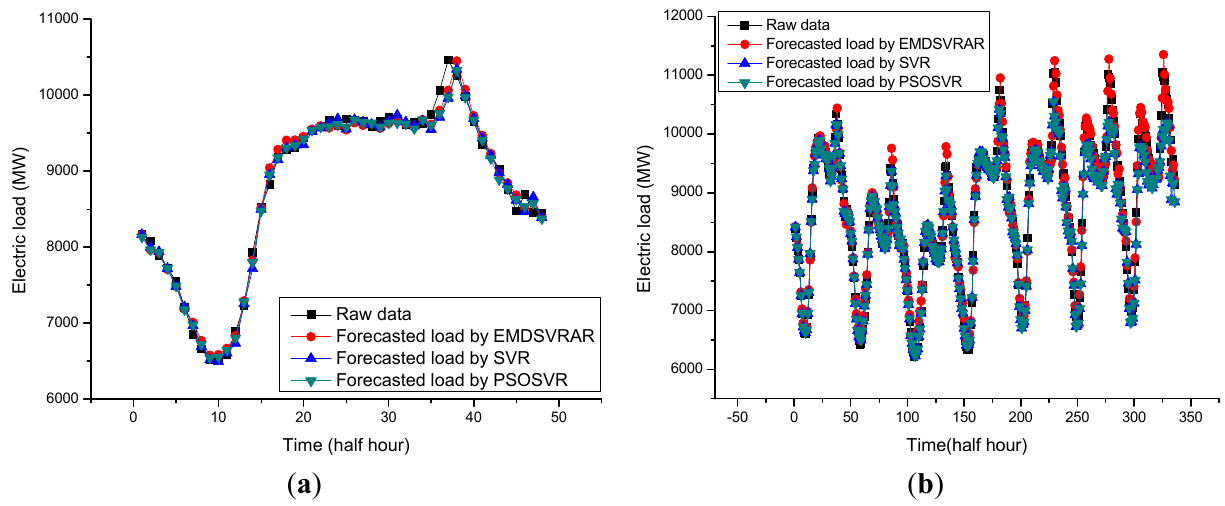
Figure 7. Comparison of the original data and the forecasted electric load by the EMDSVRAR Model, the SVR model and the PSO-SVR model for ( a ) the small sample size (One-day ahead prediction of 8 May 8, 2007 are performed by the models); ( b ) the large sample size (One-week ahead prediction from May 18, 2007 May 24, 2007 are performed by the models).